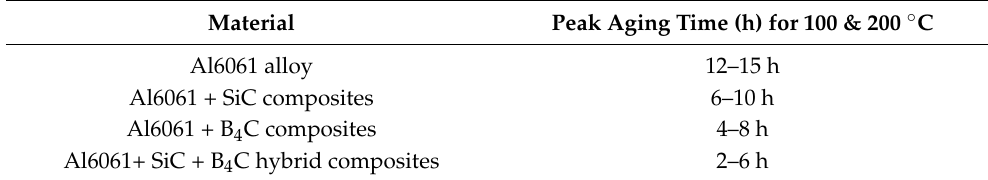
Table 4. Peak aging time obtained during aging treatment after solutionizing treatment for Al6061 alloy and its composites [4,5,18].